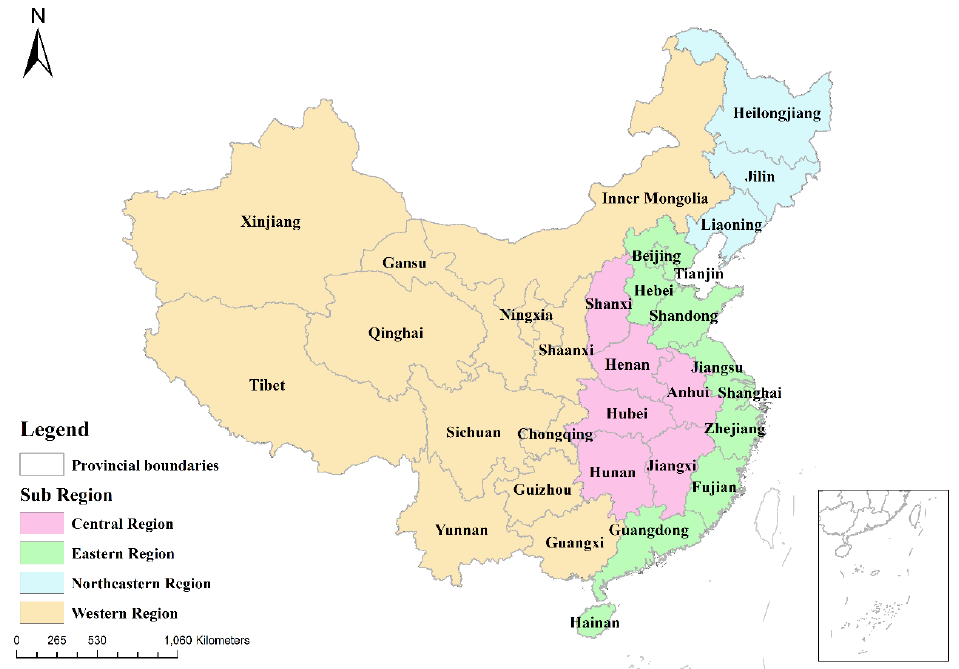
Figure 2. Study area and boundaries of the four sub regions.